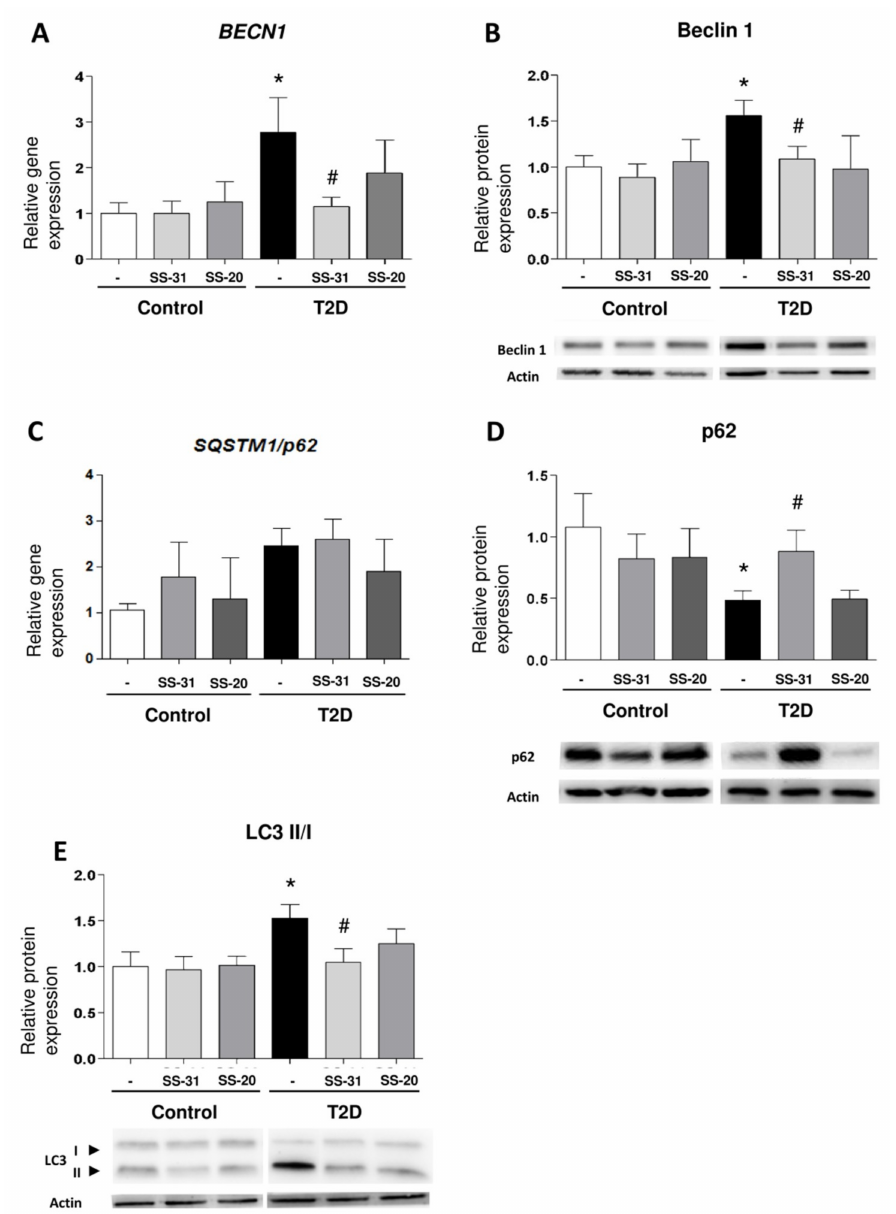
Figure 3. Study of autophagy-related parameters in leukocytes from control subjects and T2D